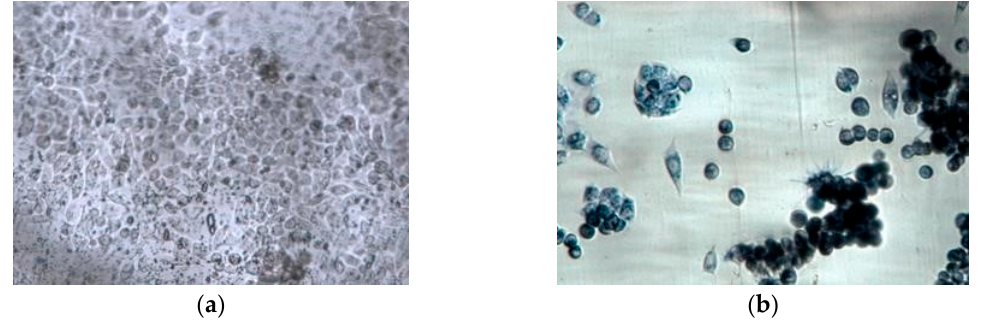
Figure 3. In-Device Seeding through Microfluidic Path of 1 × 10 5 cells/mL (representative images of HeLa cells): ( a ) Detection 24 h after seeding of adhered cells in proliferating culture; ( b ) In-Device MTT Delivery by controlled flux (7 µL/min) for 2.5 h. The MTT salts are metabolized by functional enzymes of viable cells only, which produce the precipitation of dark-blue formazan